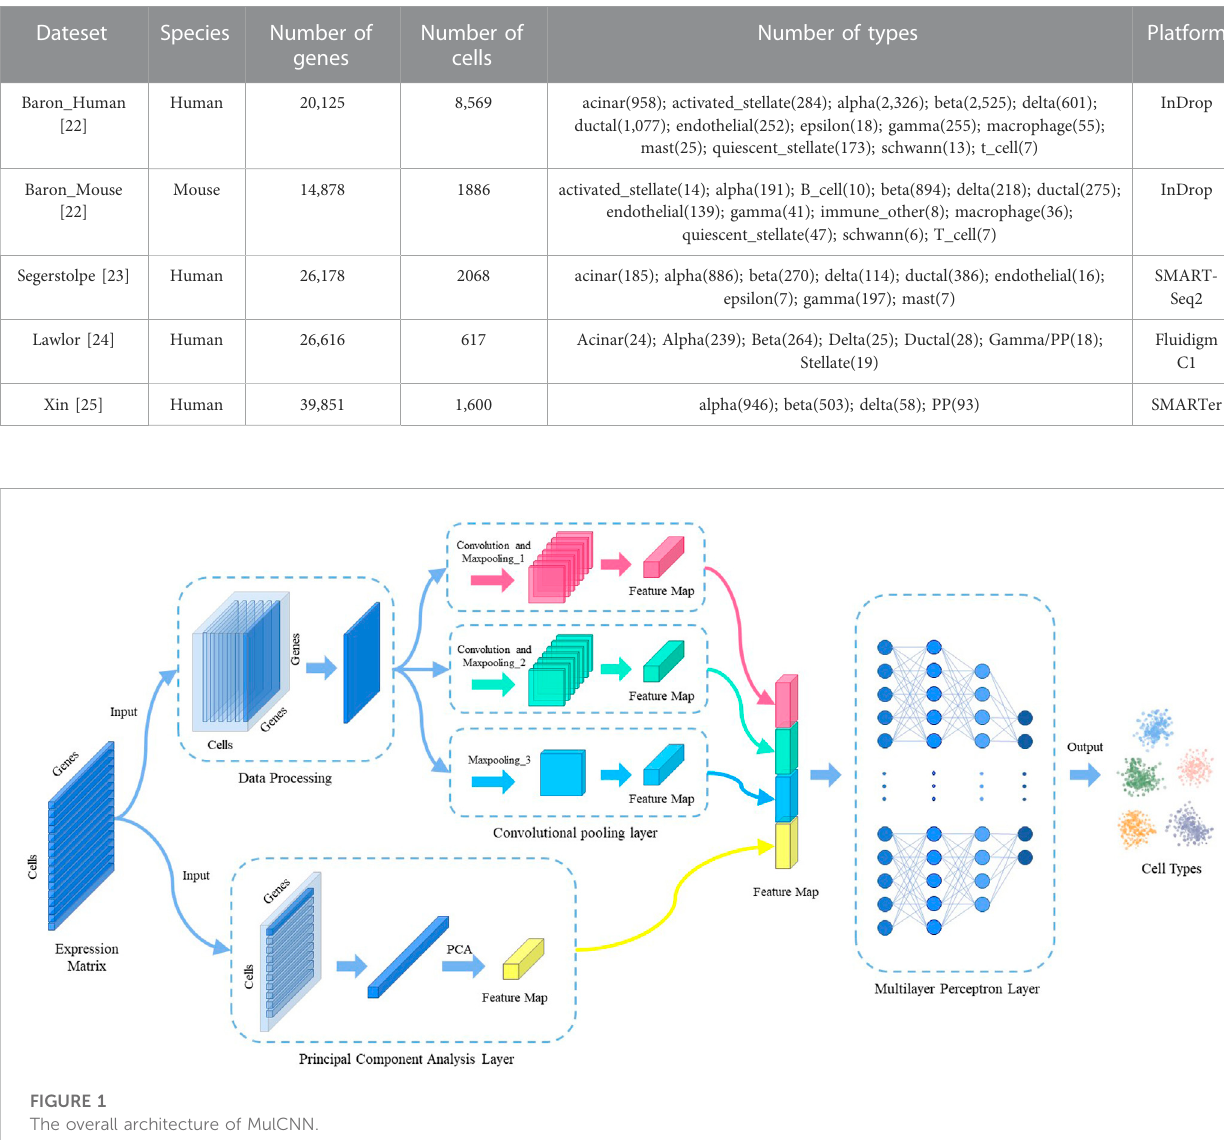
TABLE 1 Datasets analyzed in this paper.